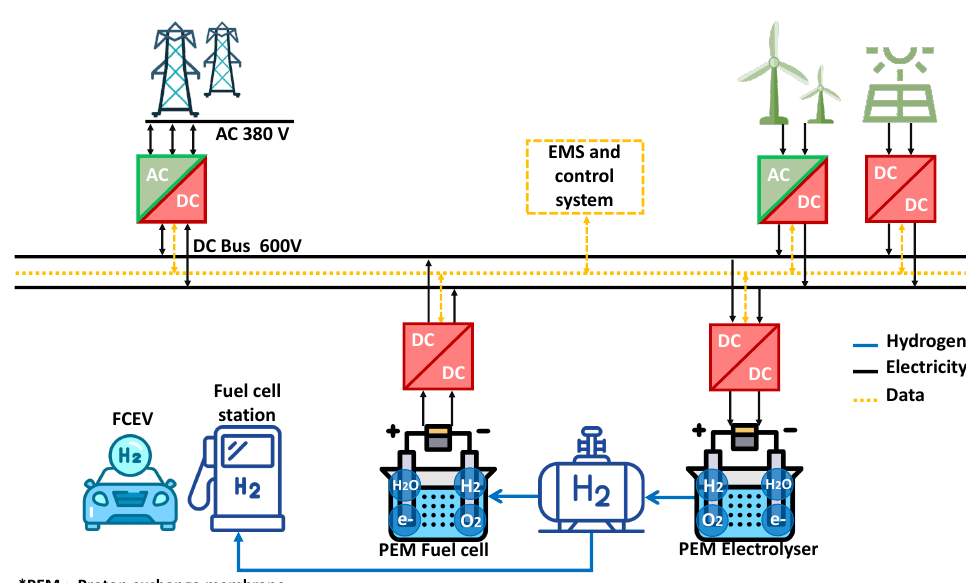
Figure 19. Green hydrogen production, storage, and